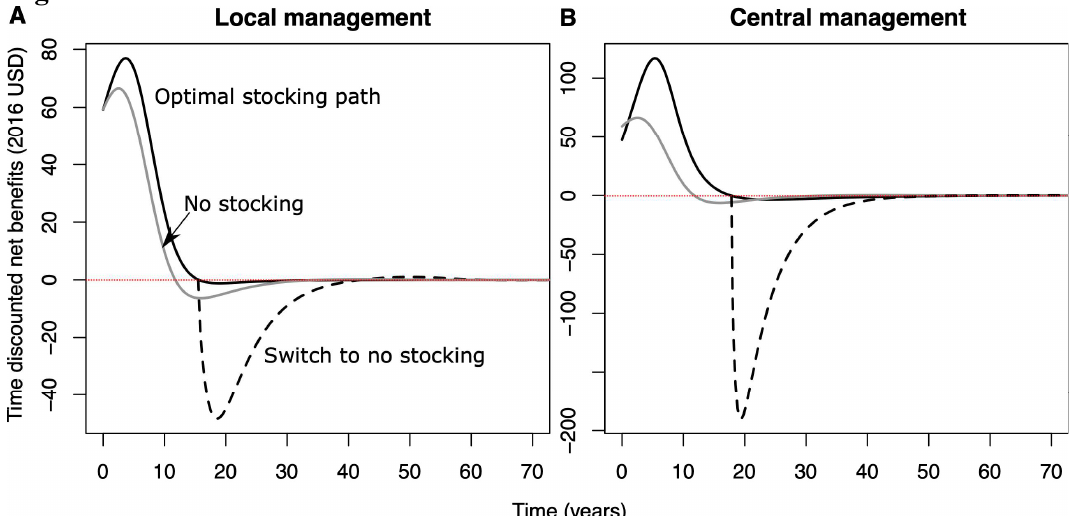
Figure A4.1. Comparison of present value of net benefits (PVNB) over time of (A) local and (B) centralized management when no stocking (gray) and optimal stocking (black) are followed. Stocking decisions are initialized from pristine conditions when there is little fishing pressure (2 angling trips per year) and the fish stock is at carrying capacity (24 fish per hectare). Near equilibrium the PVNB in the no stocking scenario is slightly higher than in the optimal stocking scenario (only visible in B). At this point (and all others) switching from the optimal stocking path to no stocking (dashed line) results in PVNB becoming more negative as effort drawn into the system from stocking leaves and anglers realize a loss in harvest benefits. Note different y-axis